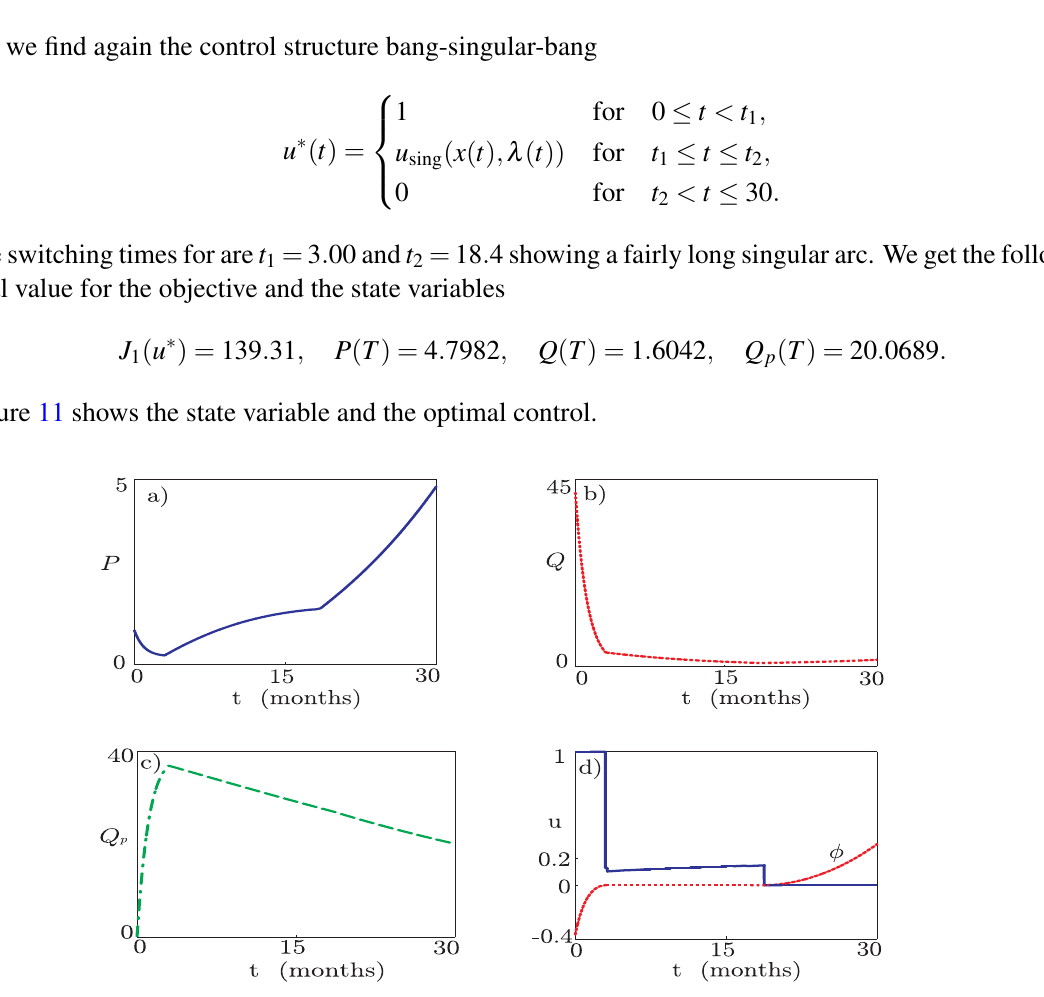
Fig. 11 Optimal solution for functional J w ( u ) in (29) with w = 1 and total dose M = 5; the time horizon is T = 30 months. Top row : a) proliferative cells P , b) nonproliferative quiescent cells Q ; Bottom row : c) damaged quiescent cells Q p , d) optimal control u ∗ ( t ) and switching function φ ; the switching function φ ( t ) is zero on the singular arc [ t 1 , t 2 ]